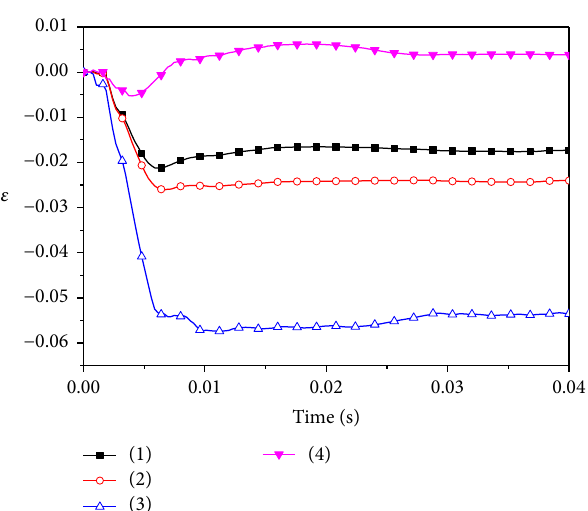
Figure 27: Strain–time history